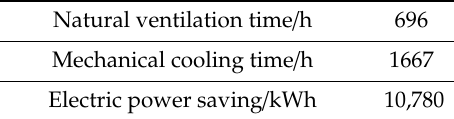
Table 9. Ventilation latent heat